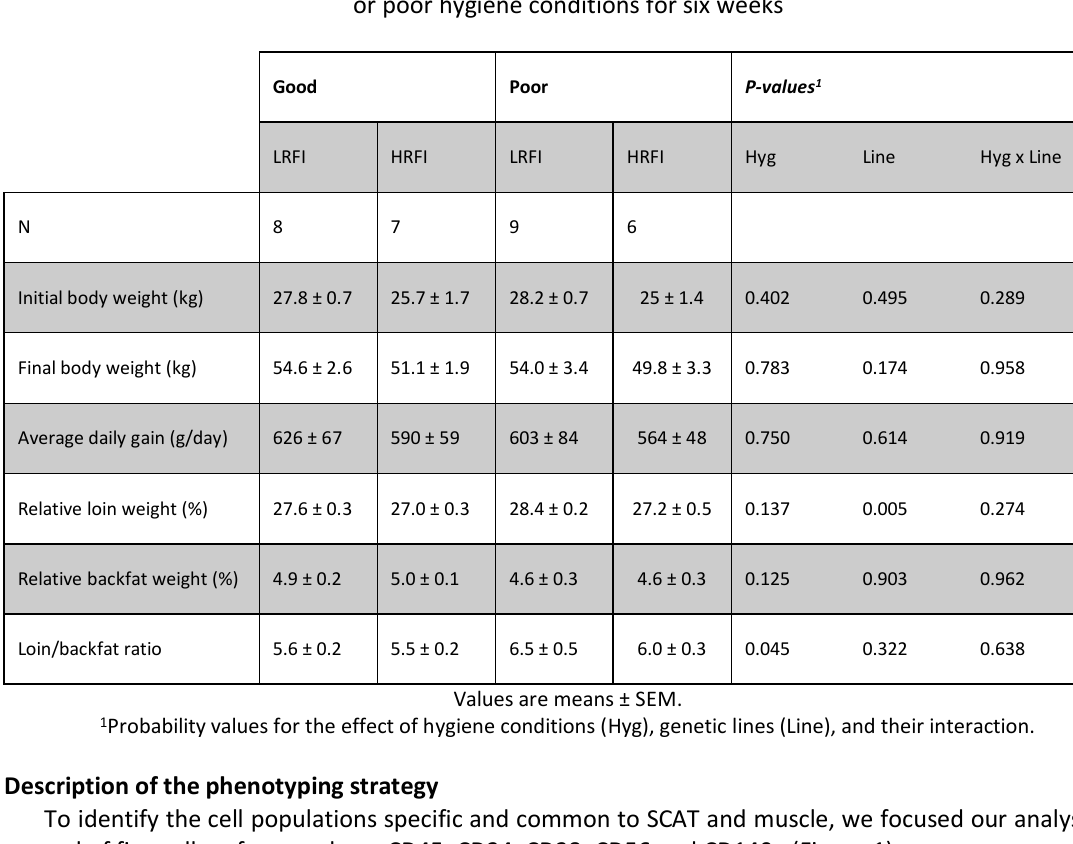
Table 2. Growth performance of low (LRFI) and high (HRFI) residual feed intake pigs housed in good or poor hygiene conditions for six weeks